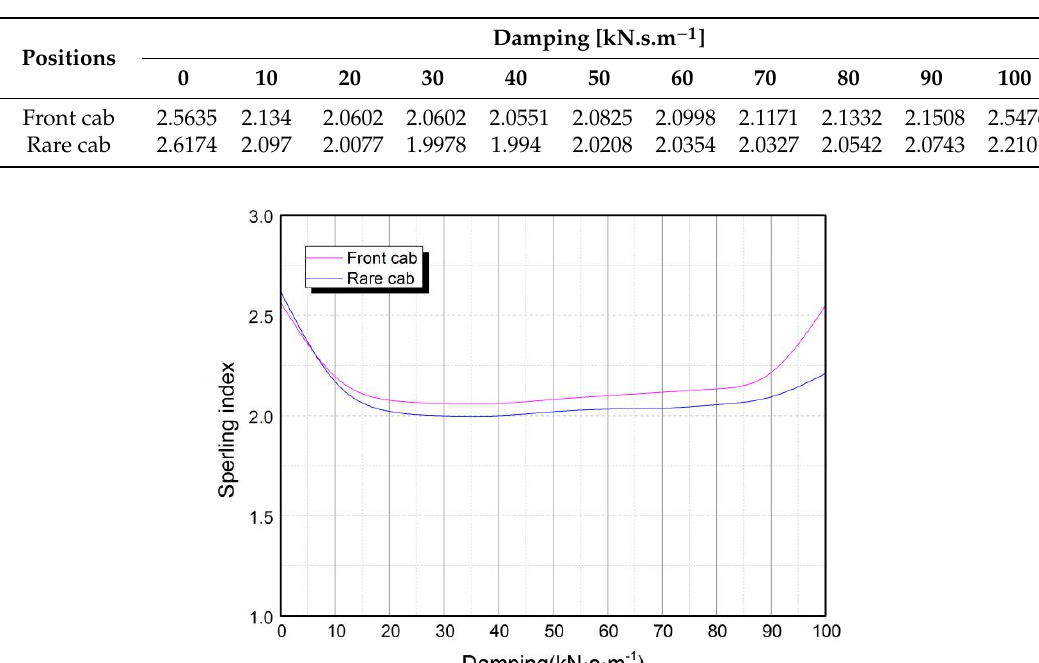
Table 1. Sperling indices.